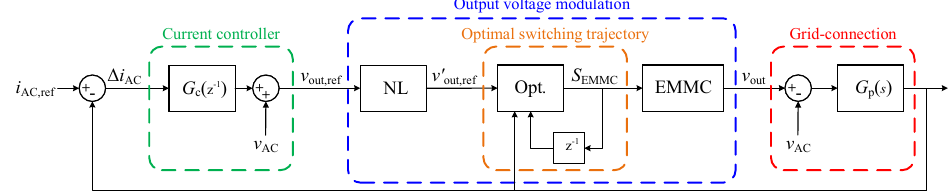
Figure 4. Current control scheme of asymmetric